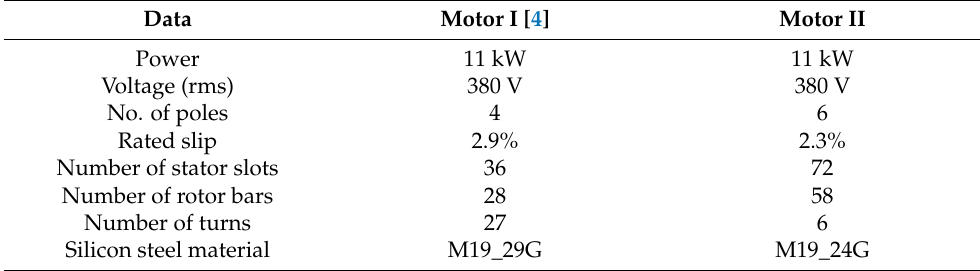
Table 1. Electrical data of the two tested motors.